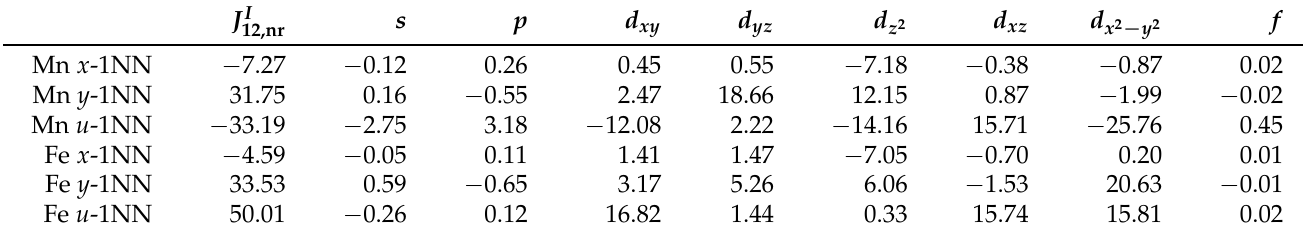
Table 2. Orbital decomposition of the isotropic exchange interaction in the 1NN Mn and Fe dimers. All values are given in meV units. Note that the SOC is turned off so the J I values slightly differ from the J I parameters given in Table 1. 12,nr 12 J I